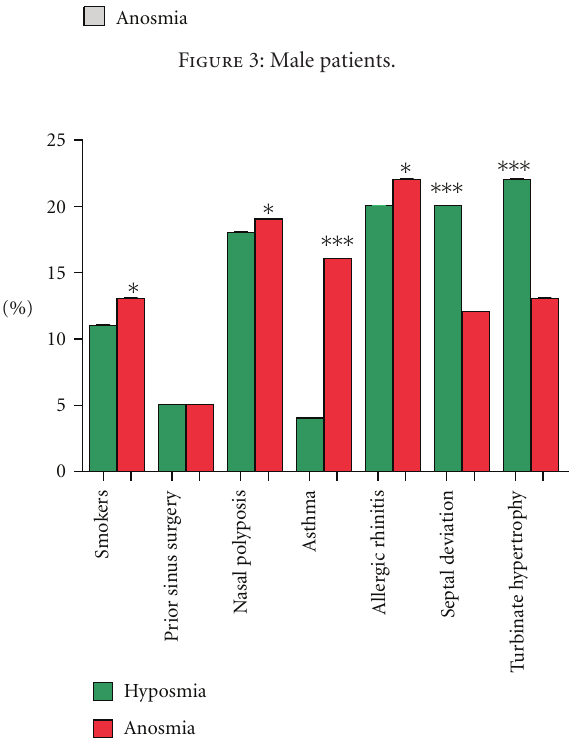
Figure 3: Male patients.